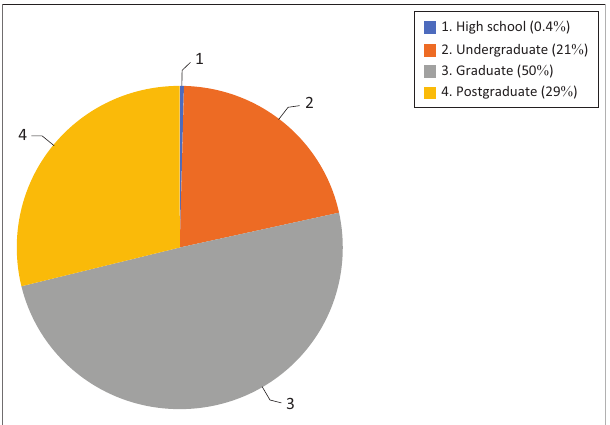
FIGURE 4: Education level of study participants.